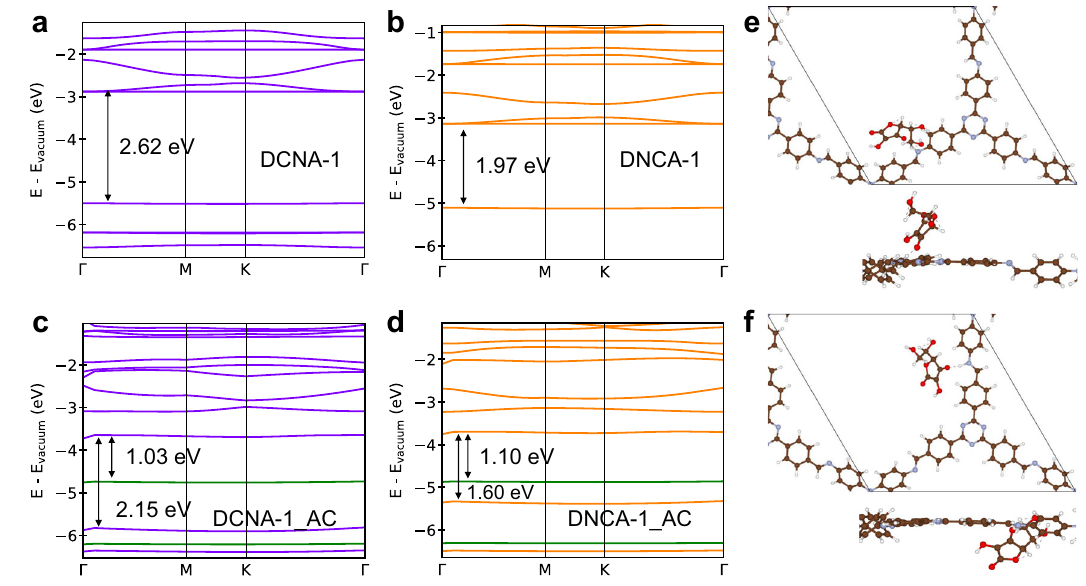
Fig. 5 | Density functional theory calculations of the COFs. Calculated HSE electronic band structures of DCNA-1 ( a ), DNCA-1 ( b ) and their protonated forms DCNA-1_AC ( c ), DNCA-1_AC ( d ). The green lines indicate states of the ascorbate anion. e , f Periodic structure models of DCNA-1_AC and DNCA-1_AC. The ascorbate